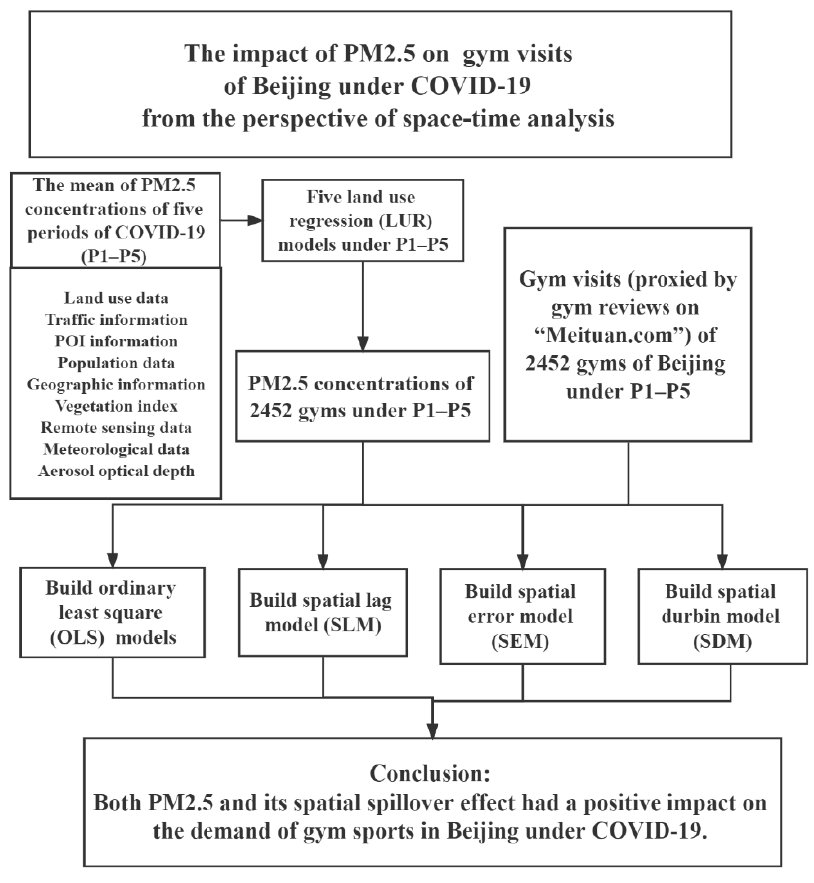
Figure 3. Theoretical framework model of this study.